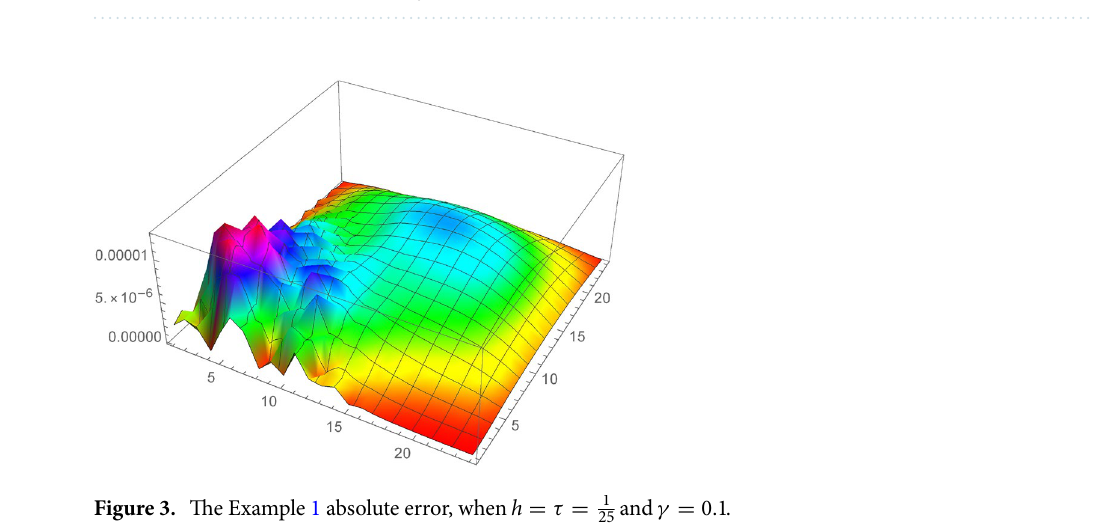
Table 10. Temporal variable convergence order for the Example 2, when h = 1 8 Temporal variable convergence order for the Example 2, when h = 1 8 .